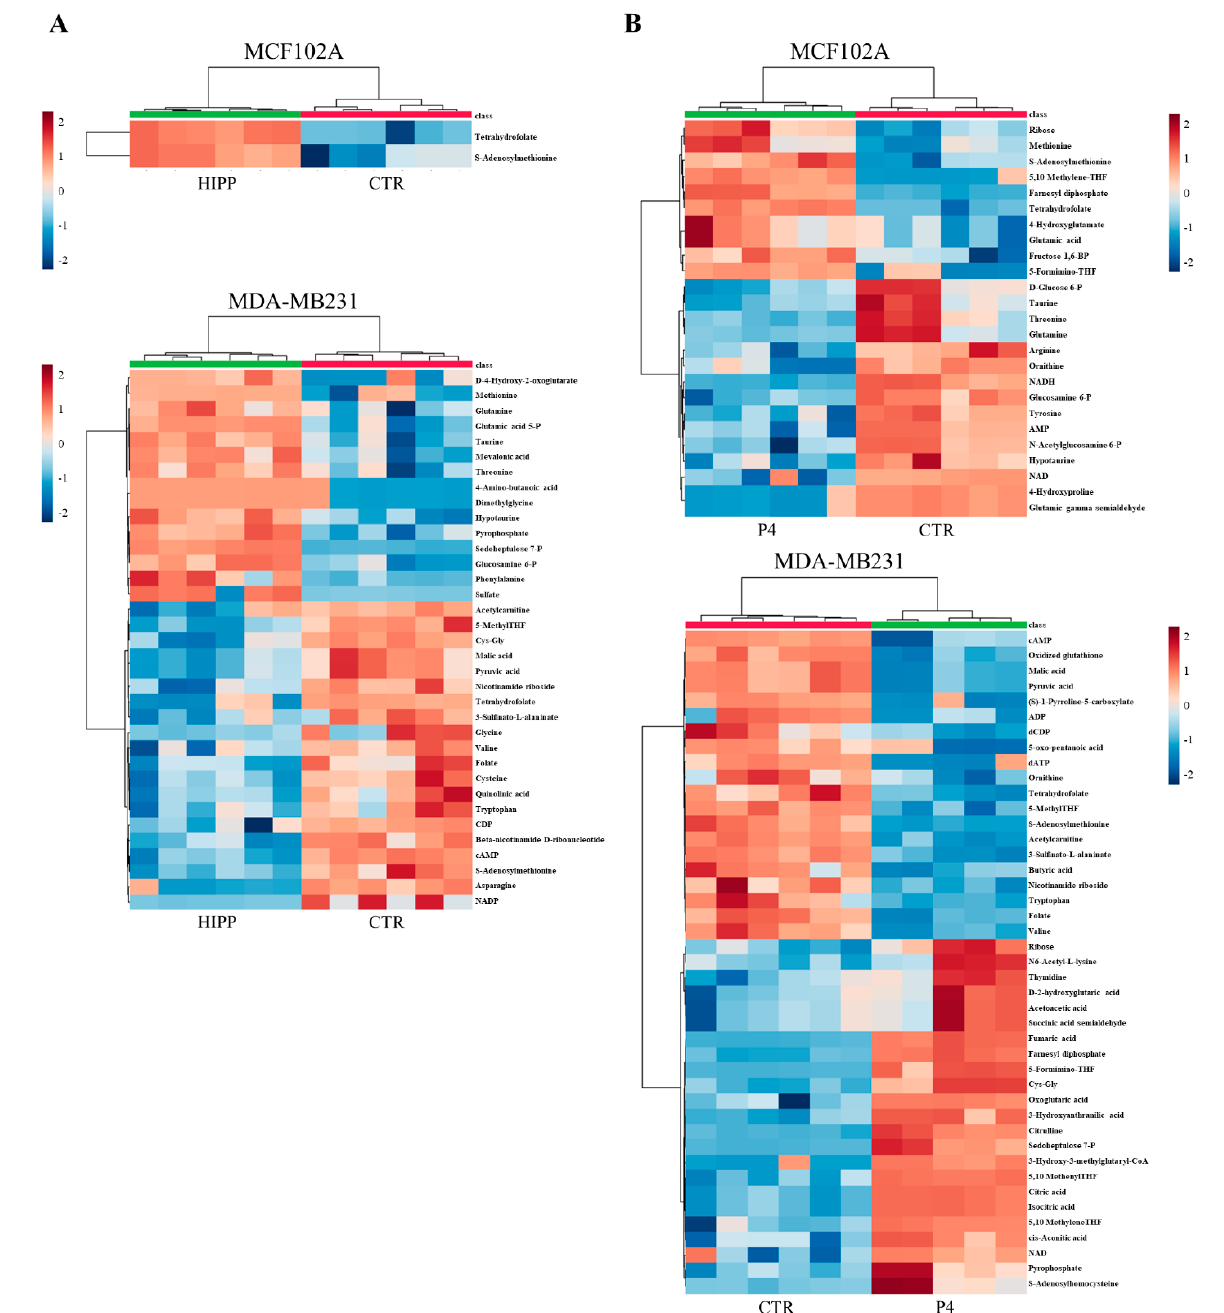
Figure 5. Metabolic profiling of MCF102A and MDA-MB231 under drug treatment. ( A,B ) Untargeted metabolic profiling of control and HIPP-treated MCF102A (upper panel) and MDA-MB231 (lower panel) cell lines ( A ), or control and P4- treated MCF102A (upper panel) and MDA-MB231 (lower panel) cell lines ( B ) grown in standard growth conditions. Hierarchical clustering heatmaps, obtained by Metaboanalyst 5.0, show significantly different intracellular metabolites detected by LC-MS.